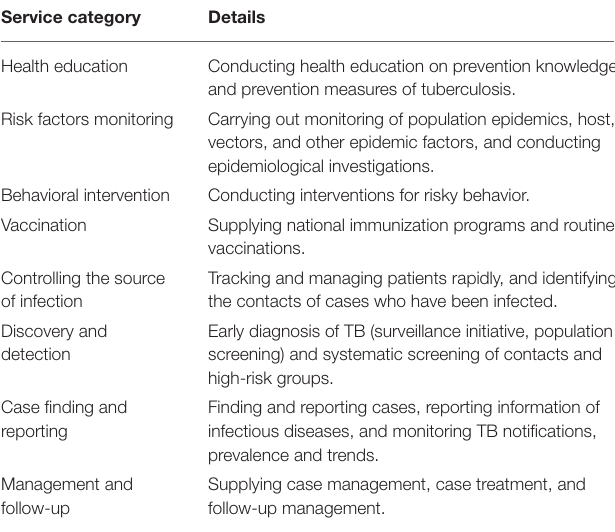
TABLE 1 | Definition of public health services for